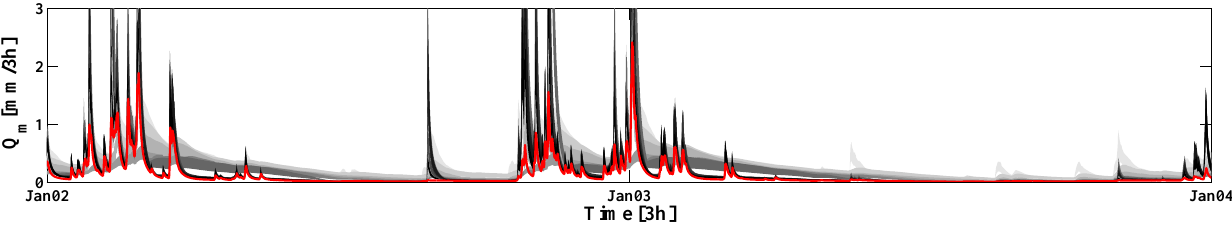
Figure 6. 95% uncertainty intervals of simulated stream flows using parameter sets satisfying different numbers of process constraints. Darker colors indicate the uncertainty intervals which satisfy more of the process constraints. The hydrograph generated by θ best is indicated in red.